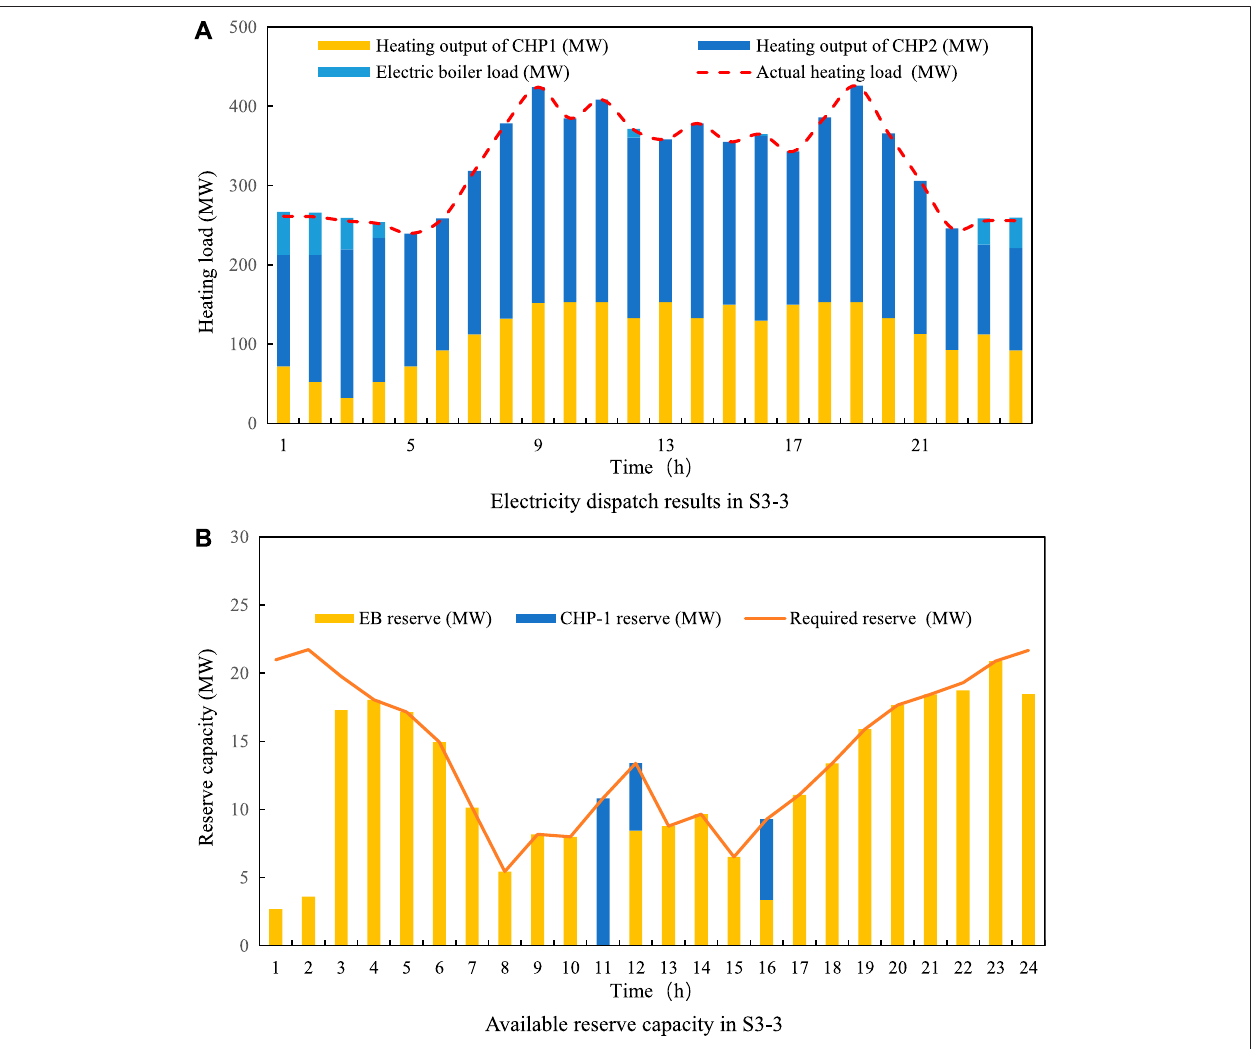
FIGURE 11 | Optimal dispatch results in